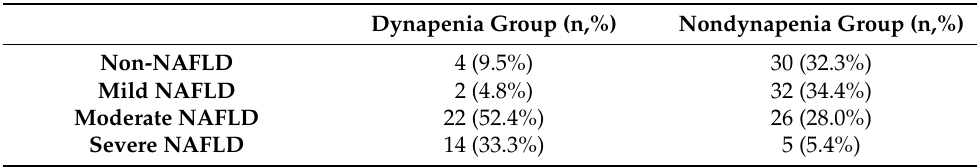
Table 4. NAFLD frequency in dynapenia-nondynapenia